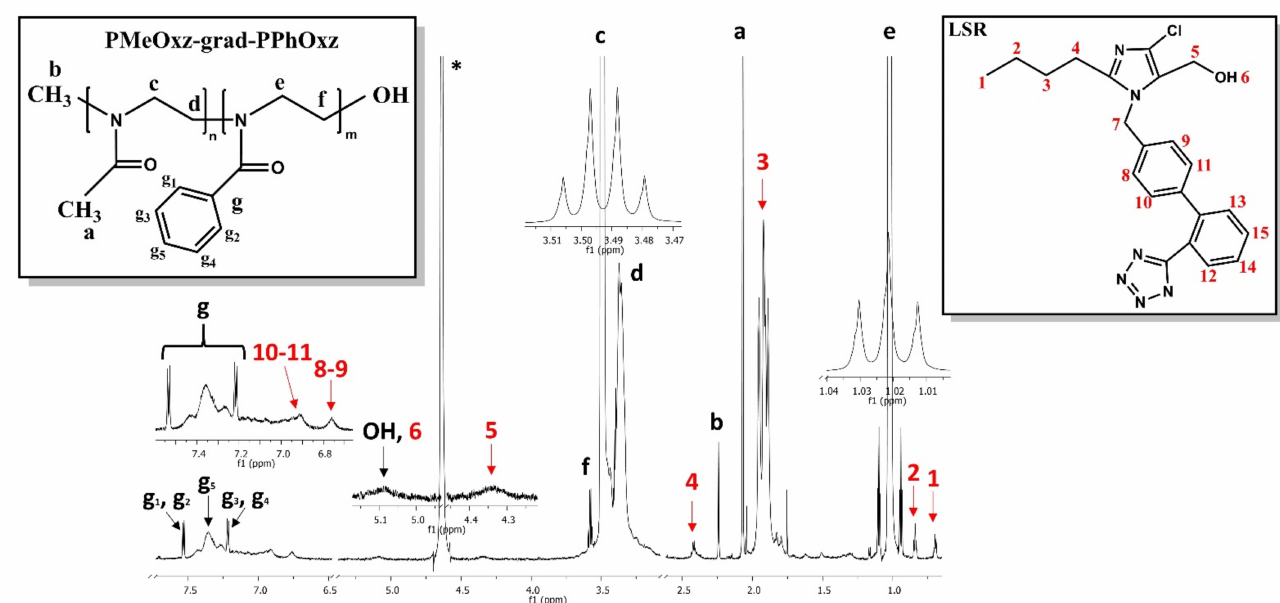
Figure 7. 1 H-NMR spectrum for the PMeOxz 72 -grad-PPhOxz 28 + 50% LSR nanocarriers in D 2 O solutions, where the black letters denote the protons of the copolymer structure (a–g), the red letters point to the LSR peaks and the symbol * refers to the solvent D 2 O. Table 5. 1 H-NMR chemical shifts of LSR in the presence of: ( a ) PMeOxz 72 -grad-PPhOxz 28